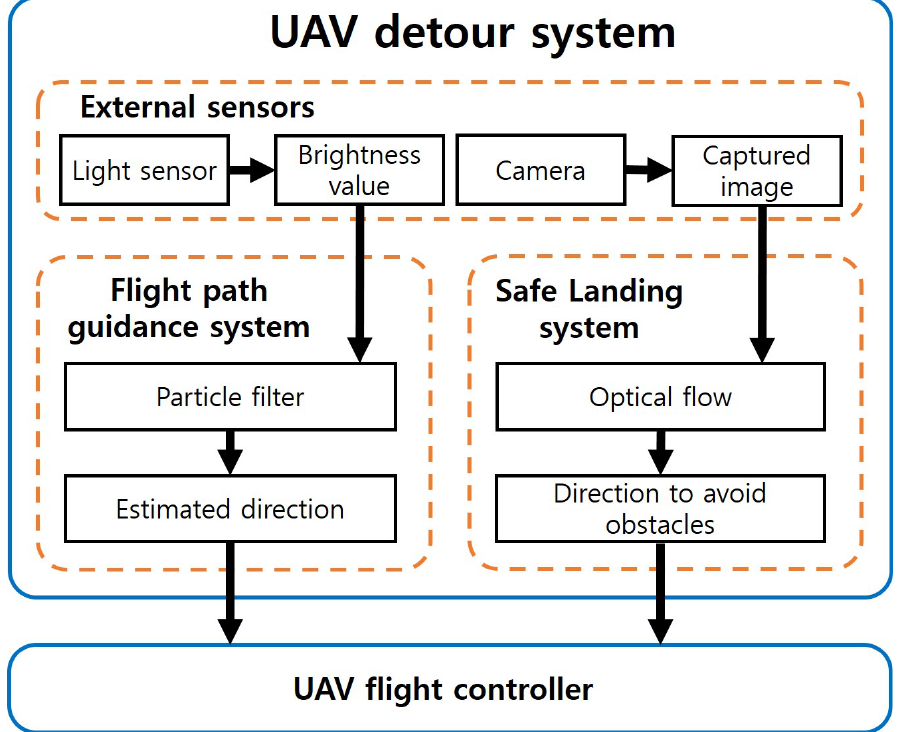
Figure 1. Overview of the unmanned aerial vehicle (UAV) detour